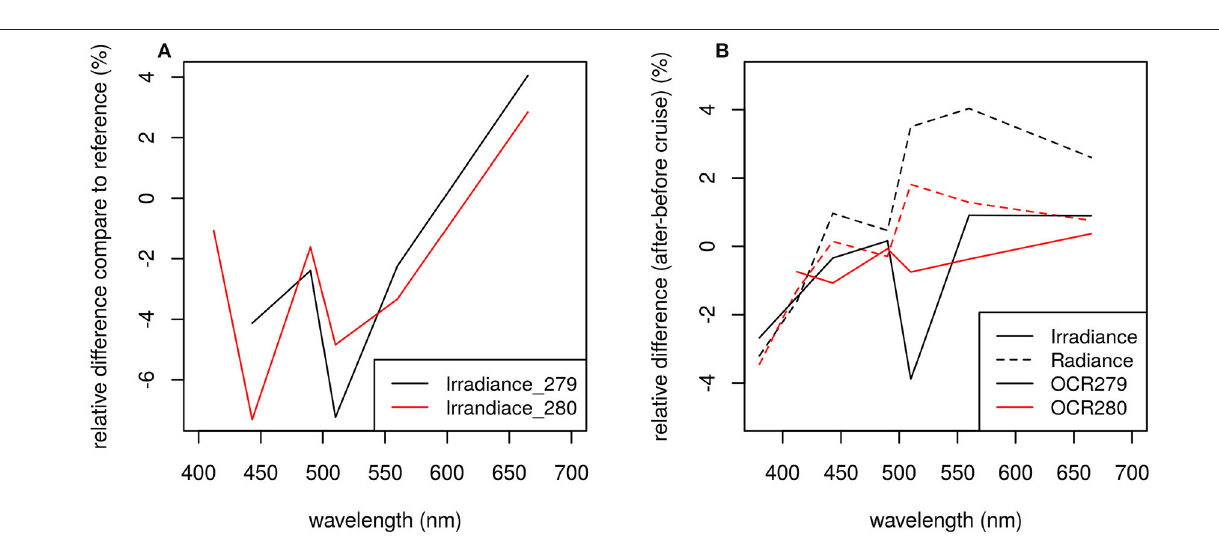
is sampled mostly at the beginning ( Figure 10 , last panel).